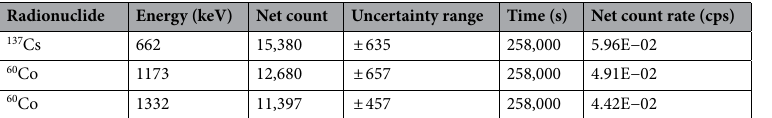
Table 9. Grid source experiment results.